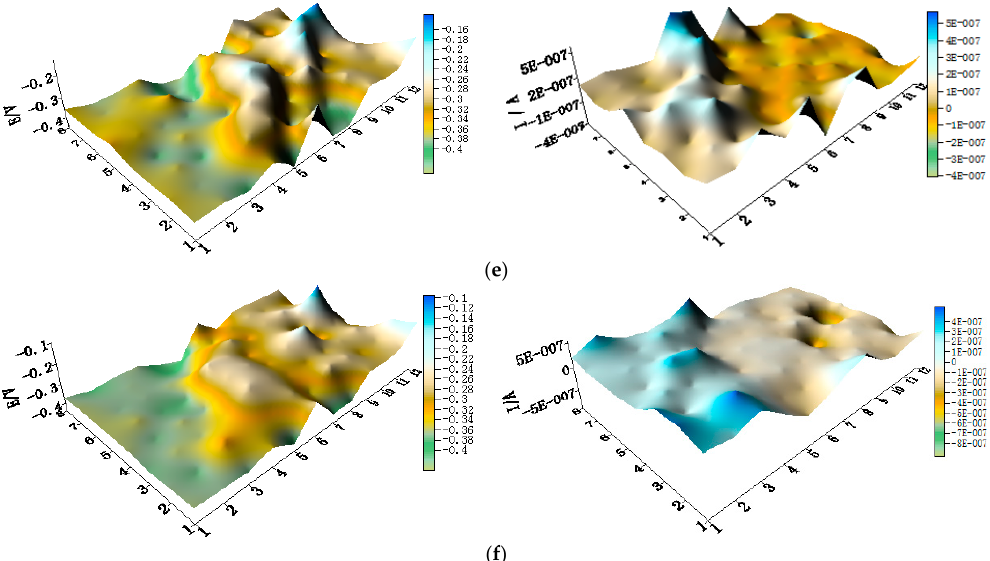
Figure 5. Spatial potential ( left , V/SCE) and corresponding current ( right , I/A) distribution maps of CMEA1 after being short-circuited for 12 h in artificial seawater with different concentrations of chloride ions (wt %): ( a ) 1.5%; ( b ) 1.7%; ( c ) 1.9%; ( d ) 2.1%; ( e ) 2.3%; and ( f ) 2.5%.